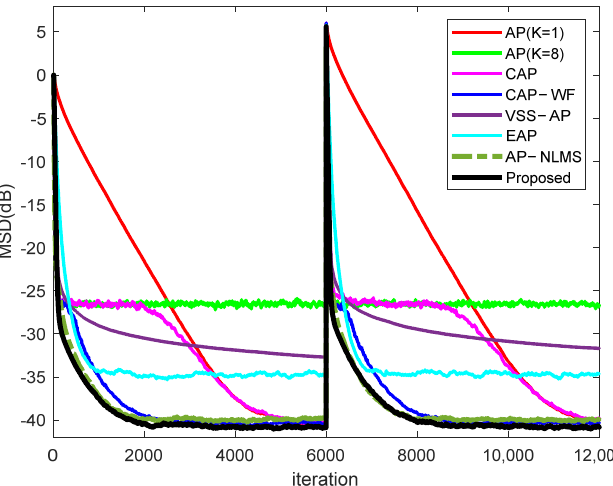
Figure 10. Convergence curves of the proposed algorithm and the conventional AP, CAP, CAP − WF, VSS − AP, EAP, and AP − NLMS algorithms in a non-stationary environment with SNR = 30 dB.